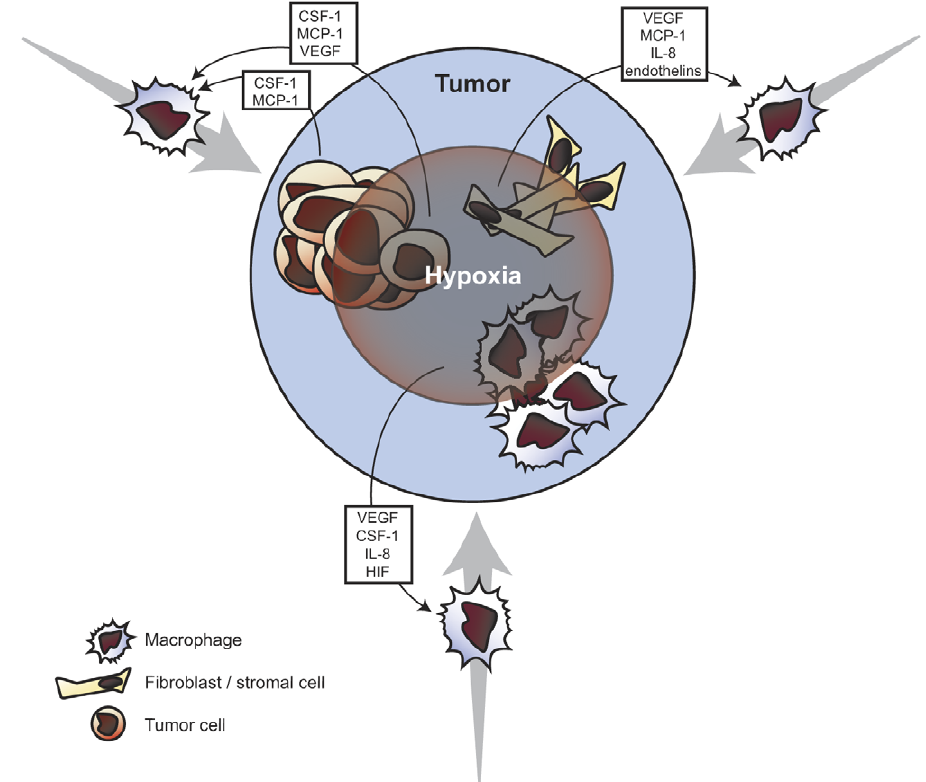
Fig. 2. Recruitment of macrophages by tumors. Tumor cells, macrophages and fibroblasts produce various chemoattractants for macrophages. Hypoxia, which is present in most tumors, attracts monocytes/macrophages and vast quantities of macrophages generally accumulate in hypoxic areas. Under hypoxic conditions secretion of many pro-angiogenic mediators is increased. Additionally, levels of various transcription factors, including HIF, are